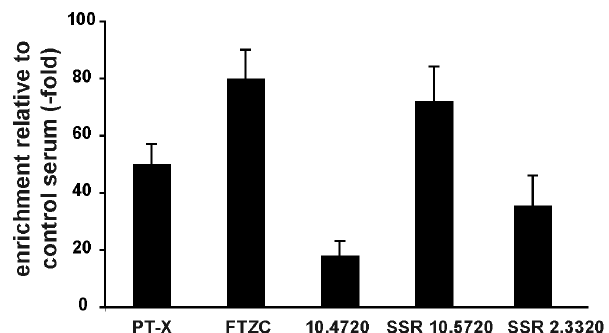
Figure 4. Validation of RBP33 targets. Quantitative RT-PCR assays were performed to confirm binding of three coding RNAs (pteridine transporter PT-X , Tb927.10.9080; flagellar transition zone component FTZC , Tb927.10.8590; and Tb927.10.4720) and transcripts derived from the SSR downstream gene Tb927.10.5720 or from the SSR downstream gene